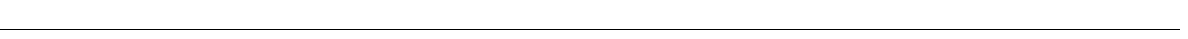
Figure 1 | Postnatal VZ and ISVZ do not generate bRGCs for the OSVZ. ( a – f ) Examples of GFP þ cells after injection of rv:: Gfp into VZ (lateral ventricle), ISVZ or OSVZ at P1, with stereotyped morphologies: apical radial glia cells (aRGCs), basal radial glia cells (bRGCs), multipolar cells (MP), migrating neuron (MN), differentiating neuron (DN) and star-like cells (StCs). DNs typically had the cell soma in the cortical plate (CP) and a single apical dendrite branching in the marginal zone (MZ). IZ, intermediate zone. ( g – k ) GFP þ aRGCs in VZ ( g , i ) and bRGCs in ISVZ ( h , j ) at P6 after ventricular injection of rv:: Gfp at P1, showing expression of Pax6 ( g , h ) and Tbr2 ( i , j ) in both populations. ( k ) Abundance of aRGCs and bRGCs expressing Ki67, Pax6 or Tbr2 (aRGCs, n ¼ 57 cells, Ki67; 82 cells, Pax6; 61 cells, Tbr2; 3 animals; and bRGCs, n ¼ 72 cells, Ki67; 59 cells, Pax6; 31 cells, Tbr2; 3 animals). ( l – u ) P1 ferrets were injected ( p , u ). Data refer to GFP þ cells across the cortical thickness. Cell lineages from these layers contained aRGCs in VZ ( n ) and abundant bRGCs in ISVZ throughout development ( o , t ; open arrowheads indicate the basal process), but null presence in OSVZ ( n ¼ 962–5,544 cells per group; Supplementary Table 1). ( v – z ) Ferrets were injected with rv:: Gfp locally into OSVZ at P1 and analysed at later stages ( z ). GFP þ bRGCs were abundant in OSVZ at all survival times ( x , y ), demonstrating local bRGC production ( n ¼ 420–3,742 cells per group; Supplementary Table 1). The relative abundance of GFP þ aRGCs and bRGCs decreased rapidly from P3 to P6 regardless of the injection site, due to the progressive accumulation of GFP þ migrating neurons (MNs; p , u , z ). Images in r and w show clusters of GFP þ cells at the injection site (asterisks), and cells retrogradely labelled in VZ (solid arrowheads). Values are mean ± s.e.m. in k , p , u and z . Scale bars, 20 m m ( a – f ); 10 m m ( g – j ); 100 m m ( m – y ) low magnifications, 20 m m